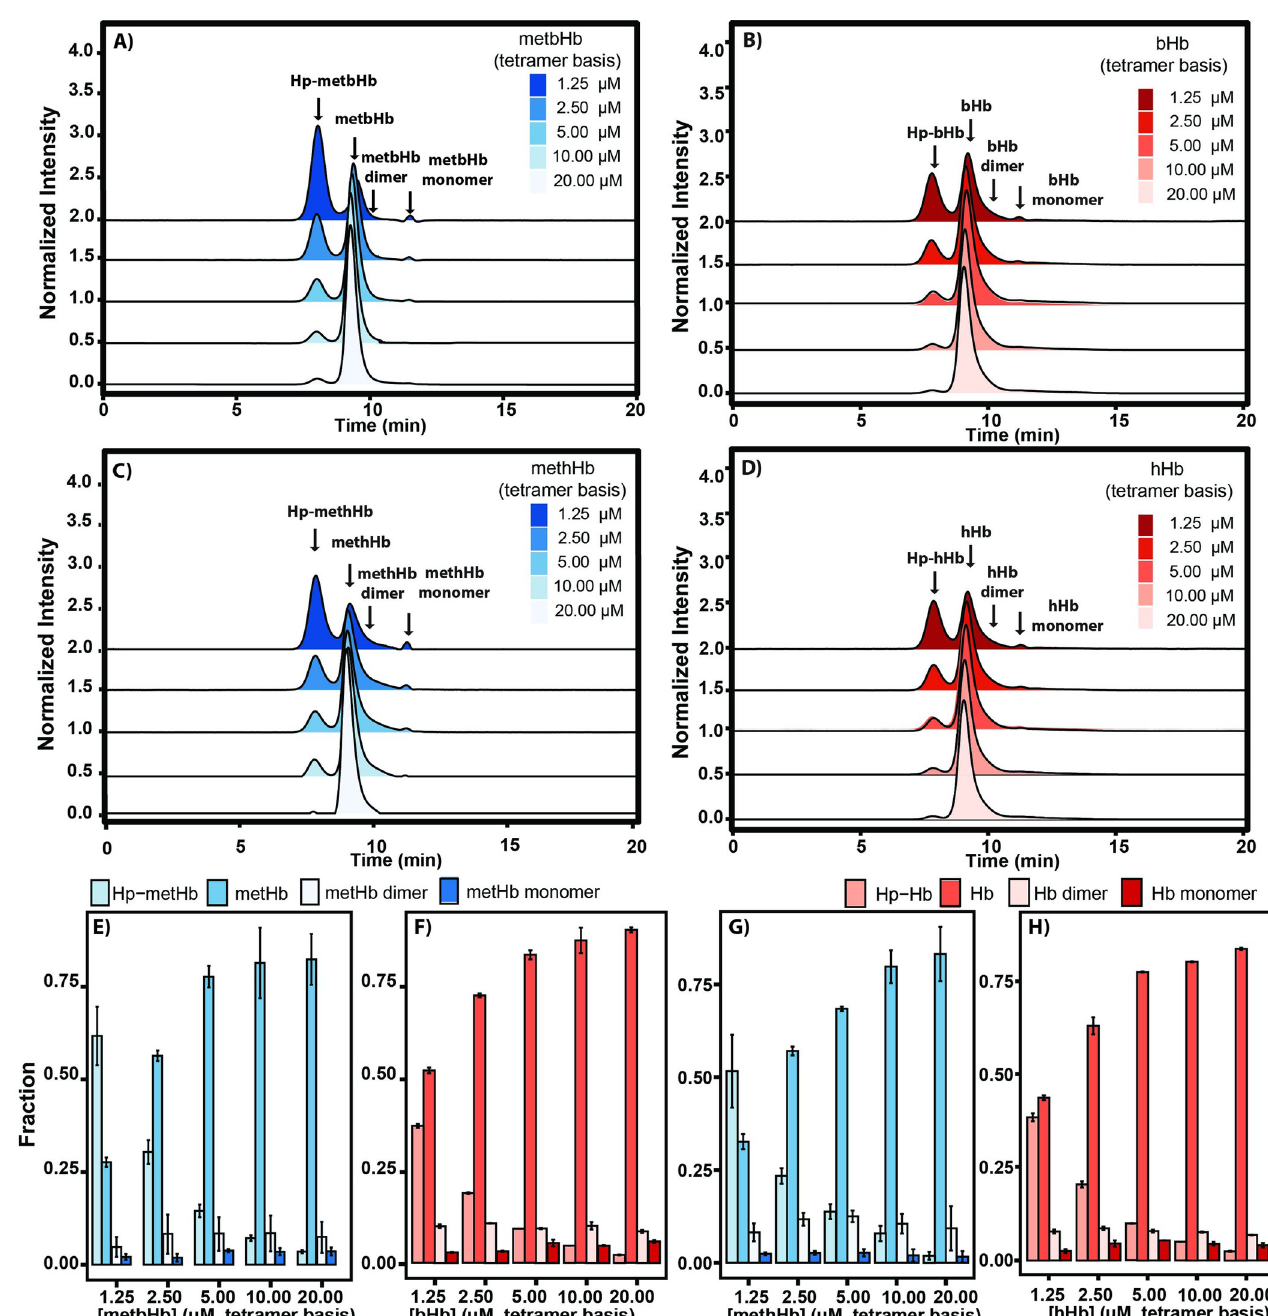
Fig 6. SEC-HPLC of Hp-metHb/Hb complexes as a function of metHb/Hb concentration. Normalized SEC-HPLC chromatograms of: (A) Hp-metbHb, (B) Hp-bHb, (C) Hp-methHb, and (D) Hp-hHb mixtures. Chromatograms were monitored at an absorbance of λ = 413 nm normalized against the total area under the curve. Hp (0.25 μ M on a Hb tetramer binding basis) was rapidly mixed with excess metHb/Hb. Composition of: (E) Hp-metbHb, (F) Hp-bHb), (G) Hp-methHb, and (H) Hp-hHb mixtures which include the Hp-metHb/Hb complex, metHb/Hb tetramer ( α 2 β 2 ), metHb/Hb dimer ( αβ ) and monomer ( α / β ) as a function of metHb/Hb concentration. (The error bars represent the standard deviation from duplicate experiments.)